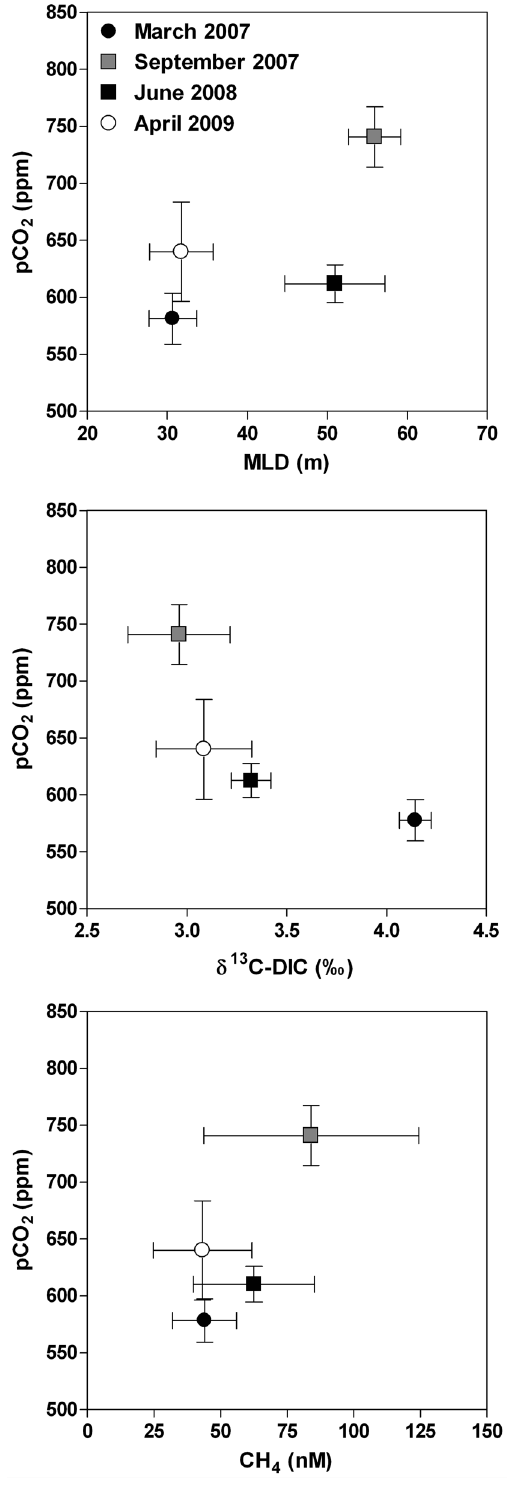
Figure 4. Average partial pressure of CO 2 (pCO 2 , ppm) in the surface waters of the main basin of Lake Kivu (1 m depth) versus mixed layer depth (MLD, m), d 13 C signature of dissolved inorganic carbon (DIC) ( d 13 C-DIC, % ), and methane concentra- tion (CH 4 , nmol L 2 1 ) in March 2007, September 2007, June 2008, and April 2009. Vertical and horizontal bars represent standard deviations. doi:10.1371/journal.pone.0109500.g004 PLOS ONE |